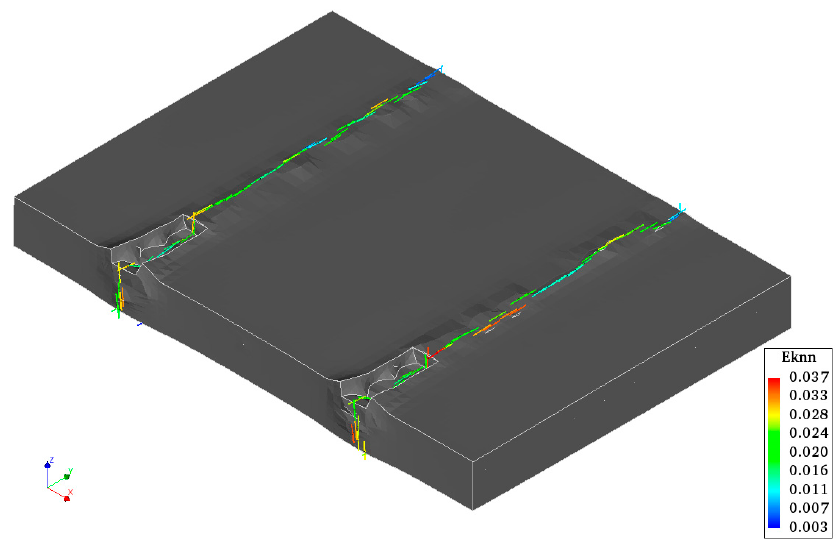
Figure 8. Crack propagation along the width of concrete slab.